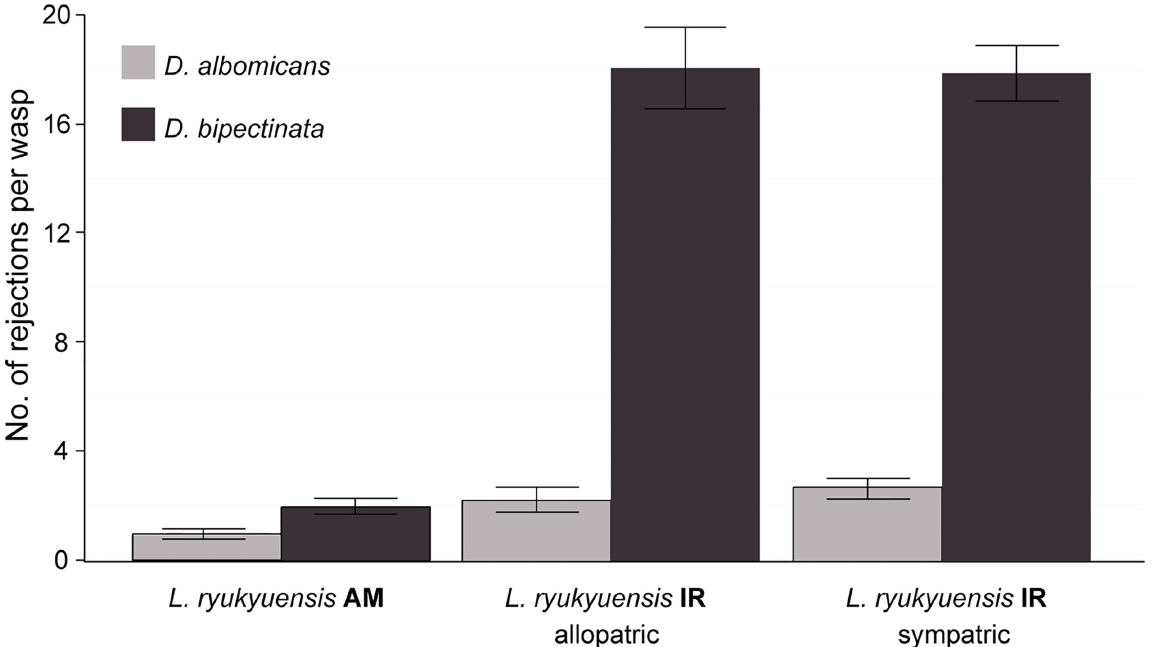
Fig 7. Number of rejections per wasp during an oviposition sequence. Rejection of NH flies by AM wasps, NH flies by IR wasps, and IR flies by IR wasps. Oviposition sequence is measured as 20 successful subsequent oviposition events. Average and standard error are shown.